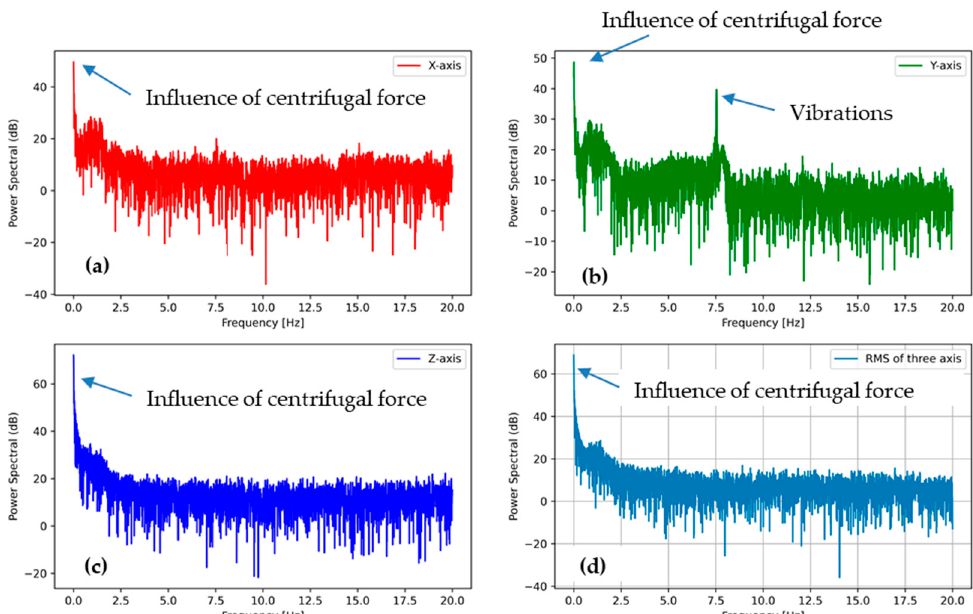
Figure 11. PSD of the accelerometer outputs from tumble phase (high-speed rotation 400 RPM) ( a ) in the X direction, ( b ) in the Y direction, and ( c ) in the Z direction, ( d ) the sum of all the accelerations.